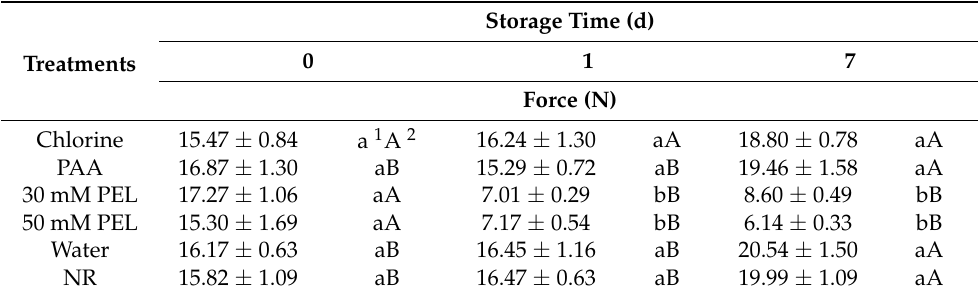
Table 4. Effect of the interactions among sanitizer treatments (including water and NR controls) and storage time on tomato surface compression (N; n =